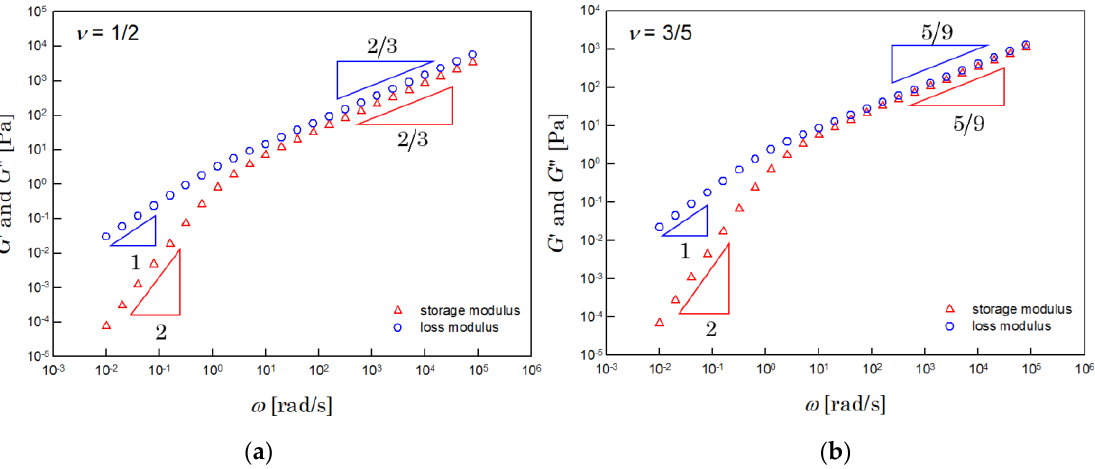
Figure 2. Dynamic moduli of the ( a ) Θ (when υ = 1/2) and ( b ) athermal (when υ = 3/5) solutions. These results were calculated by numerical integration with Equation (7), when H c = 1Pa and 1s . λ max = max